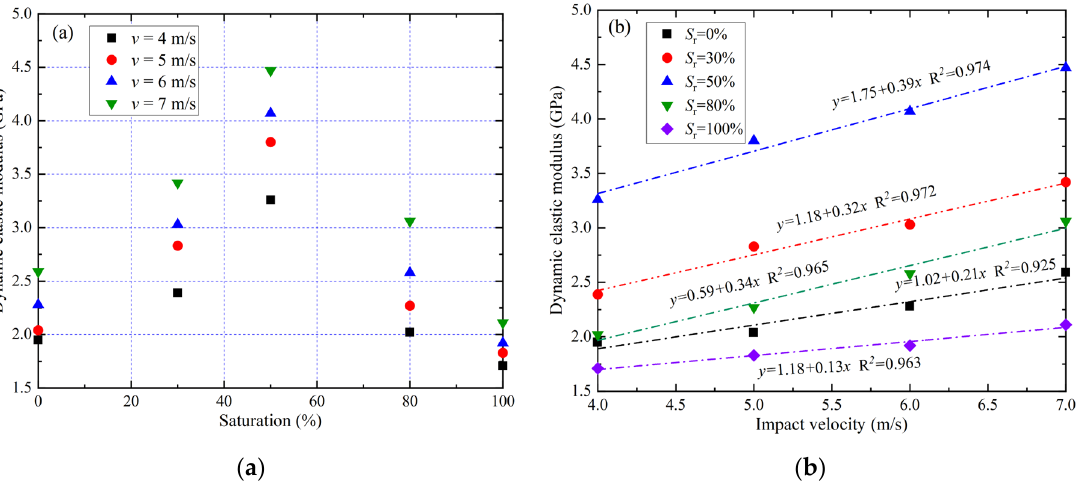
Figure 13. Dynamic elastic modulus versus saturation ( a ) and impact velocity ( b ) of the sample. Dynamic Brittleness Index